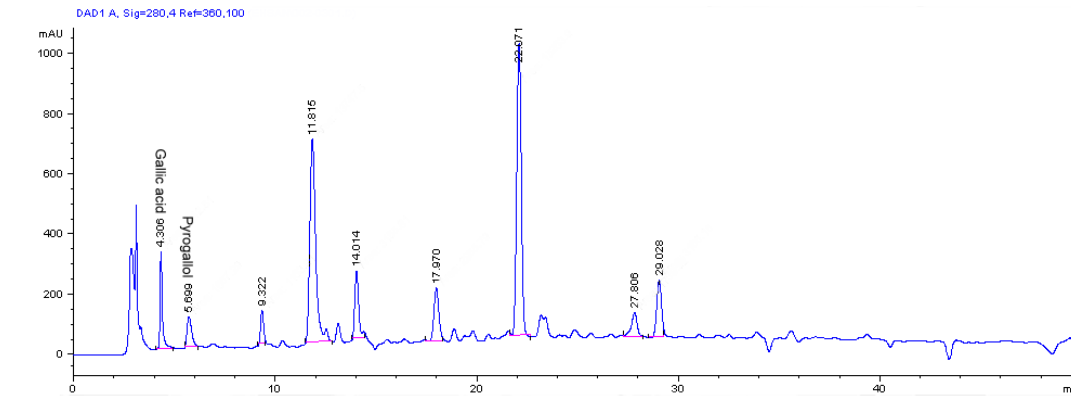
Figure 5. The RP - HPLC chromatogram of phenolic and flavonoid compounds in methanolic extract of C. sativus L.